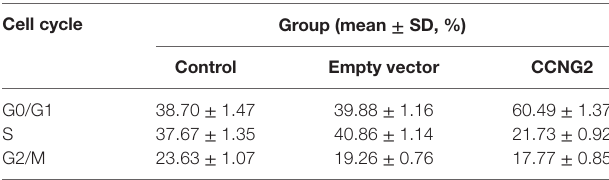
Table 4 | Distribution of the cell cycle in the U251 cell line after transfection. cell